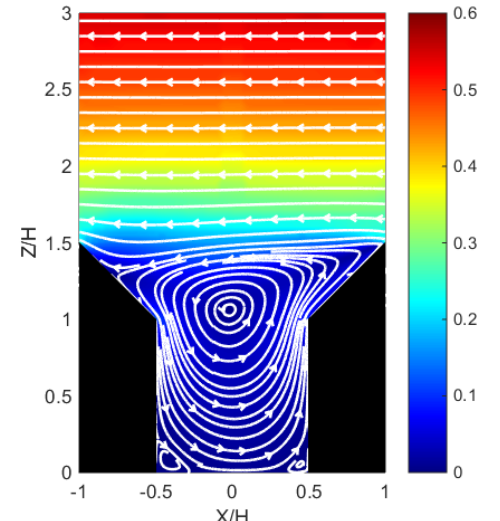
Fig. 8. Mean field of the non-dimensional intensity of the velocity, U/U 0 , for pitched roof (U 0 is the free-stream velocity); the flow moves from the right to the left; the white lines are streamlines.